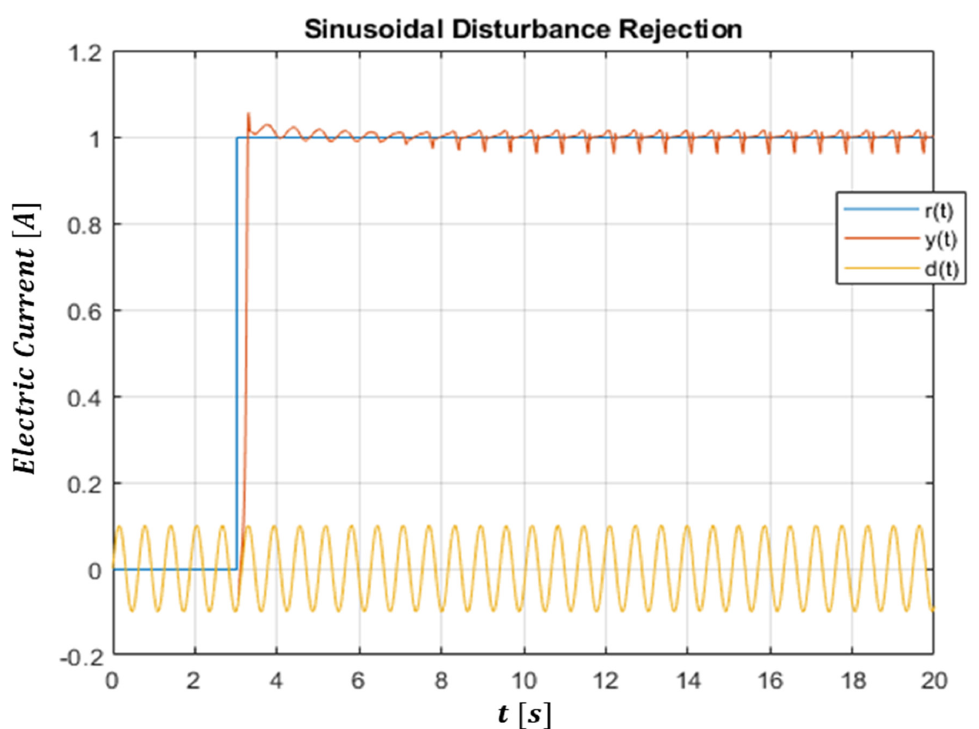
Figure 11. Comparison between current reference 𝑟(𝑟) , current supplied by the motor 𝑦(𝑡) and current disturbance 𝑑(𝑡) . disturbance d ( t )